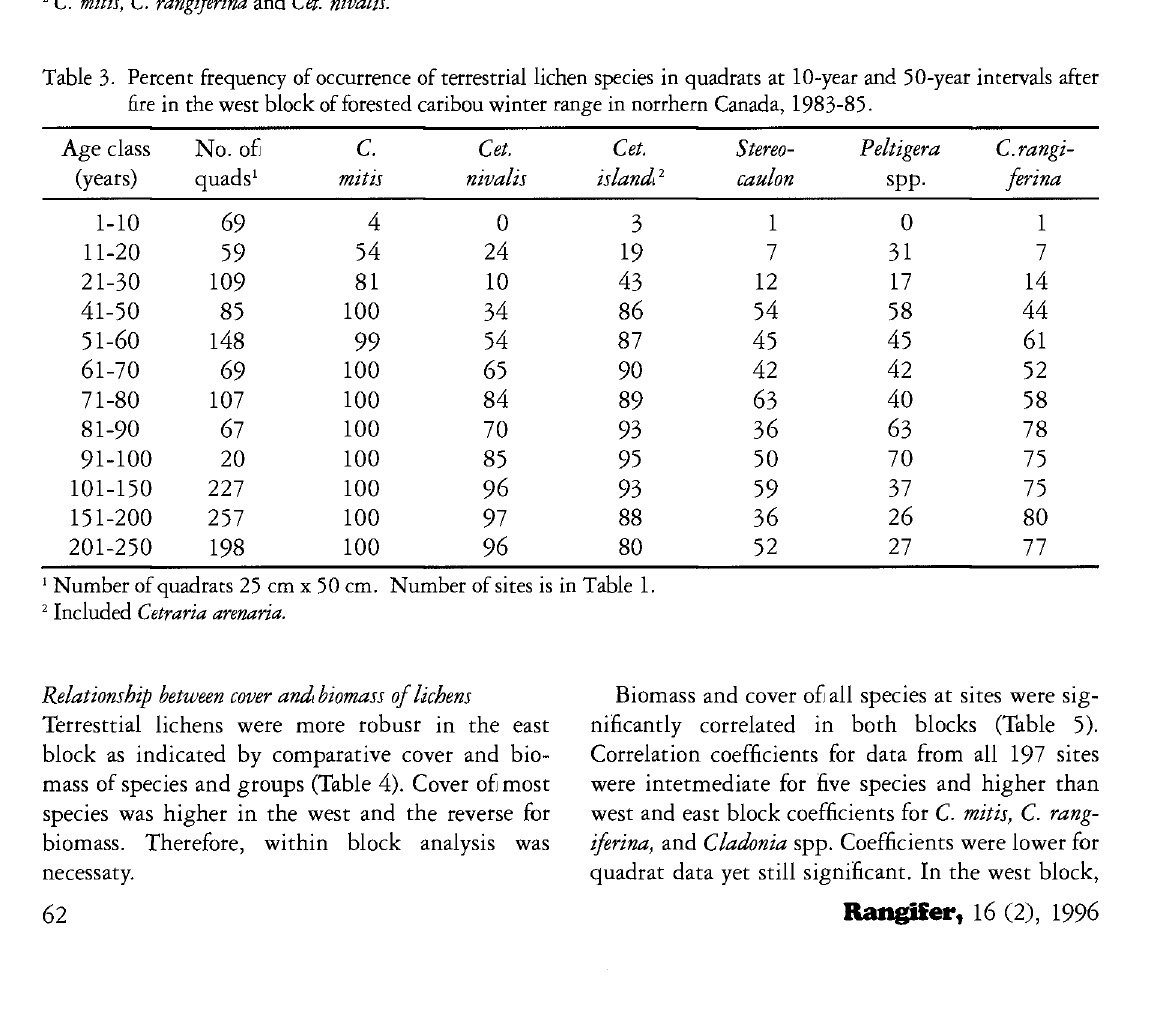
Table 3. Percent frequency of occurrence of terrestrial lichen species in quadrats at 10-year and 50-year intervals after fire in the west block of forested caribou winter range in norrhern Canada, 1983-85. Age class N o. of C. Cet. Cet. Stereo- P eltigera C. rangi (years) quads 1 mitis nivalis island.